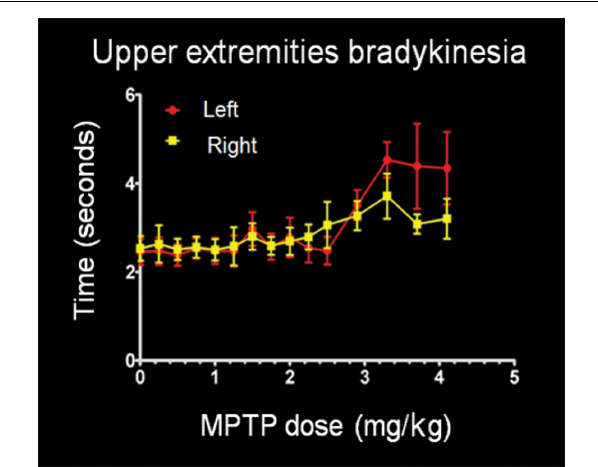
FIGURE 1 | Motor behavior. Evolution of hand bradykinesia using the peanuts test in the case-study monkey with asymmetric involvement of the nigrostriatal dopaminergic system.The left hand (contralateral to the Primary Affected Side ) exhibits a progressive increase in time taken to complete the test in parallel with increased 1-methyl-4-phenyl-1,2,3, 6-tetrahydropyridine (MPTP) total dose, while the right hand shows modest involvement.